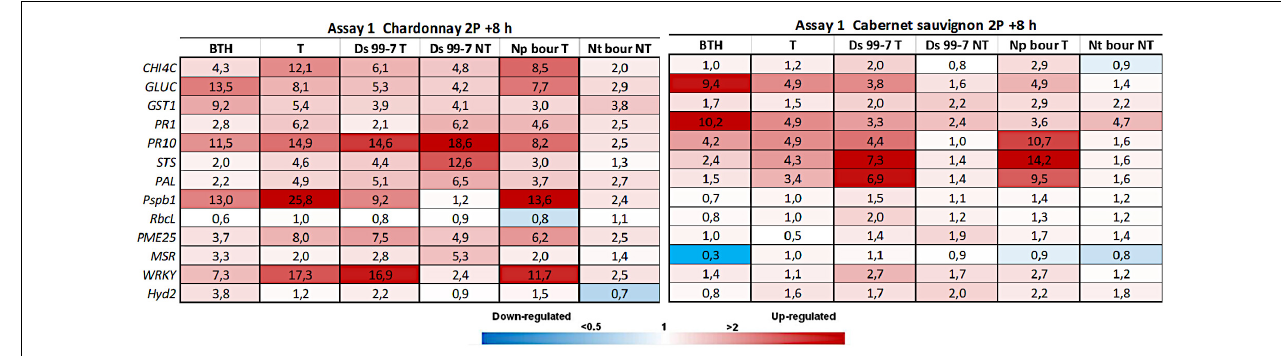
FIGURE 2 | Expression levels of the selected 13 genes recorded by RT-qPCR in “Chardonnay” and “Cabernet sauvignon” 8h after the second LC2017 treatment (2P) in Assay 1. Values (mean of three technical replicates) represent the expression levels ( (cid:49)(cid:49) Ct) of reported conditions relatively to the control (NT). Expression of a given gene was considered up- or down-regulated when value of relative expression was > 2-fold or < 0.5-fold compared to the control,